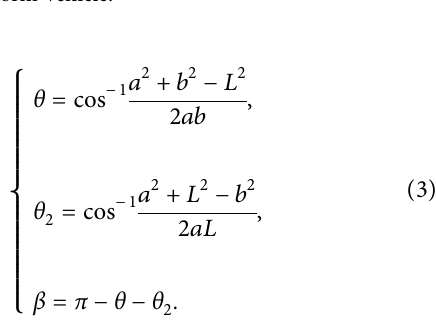
Figure 6: Force analysis diagram of the testing platform